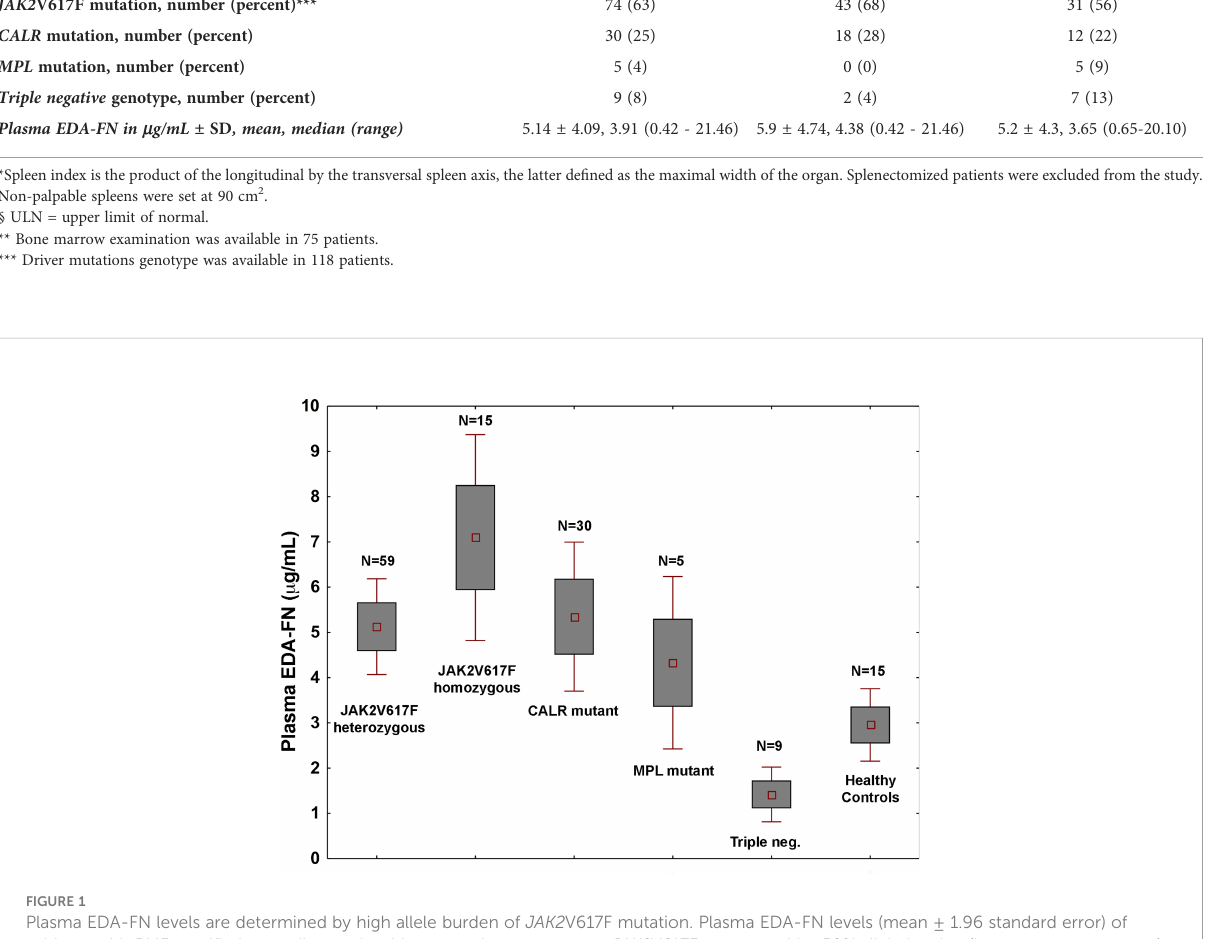
FIGURE 1 Plasma EDA-FN levels are determined by high allele burden of JAK2 V617F mutation. Plasma EDA-FN levels (mean ± 1.96 standard error) of subjects with PMF strati fi ed according to the driver mutations genotypes. JAK2 V617F mutants with >50% allele burden (homozygous genotype) had the highest mean EDA-FN plasma concentration (N=15, mean value = 6.73 m g/mL, range, 2.16 - 19.16). The mean value of EDA-FN in homozygous JAK2 V617F genotype was higher than in other genotypes together (N=103, mean value = 4.73 m g/mL, P=0.015) and in heterozygous JAK2 V617F genotype (N=59, mean value = 4.85 m g/mL; P=0.036). Triple negative subjects had the lowest plasma EDA-FN concentration (N=9; mean value = 1.29 m g/mL; range, 0.75 to 6.28); their value was not different from those of healthy controls and was signi fi cantly lower than those with MPL mutation (N=5, mean value = 5.11 m g/mL, range, 2.57 to 10.82; P=0.016) and CALR mutations (N=30; mean value = 5.65 m g/mL, range, 0.65 to 20.11; P=0.039).